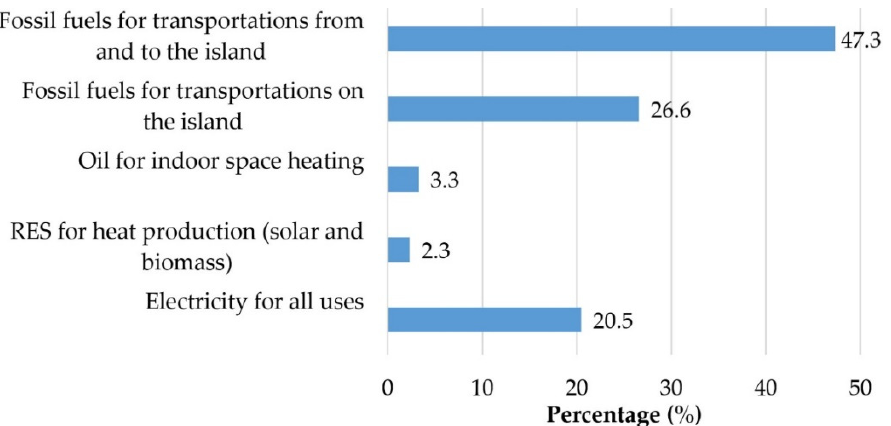
Figure 5. Percentage share of annual energy use in Crete per energy